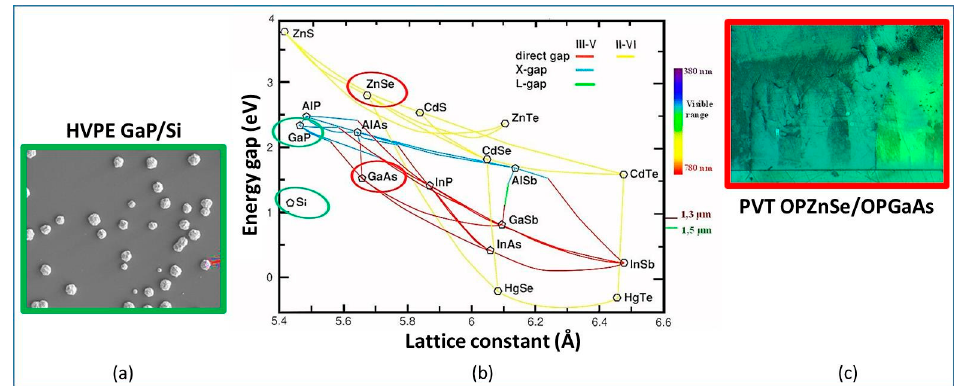
Figure 13. ( a ) HVPE growth of GaP directly on Si; ( b ) Bandgap energy vs lattice constant for some of the most popular semiconductor materials (Reproduced from [65] with some modifications); ( c ) Physical vapor transport growth of OPZnSe on a OPGaAs template [64]. (Reproduced from [64] with the permission of J. Cryst. Growth ).